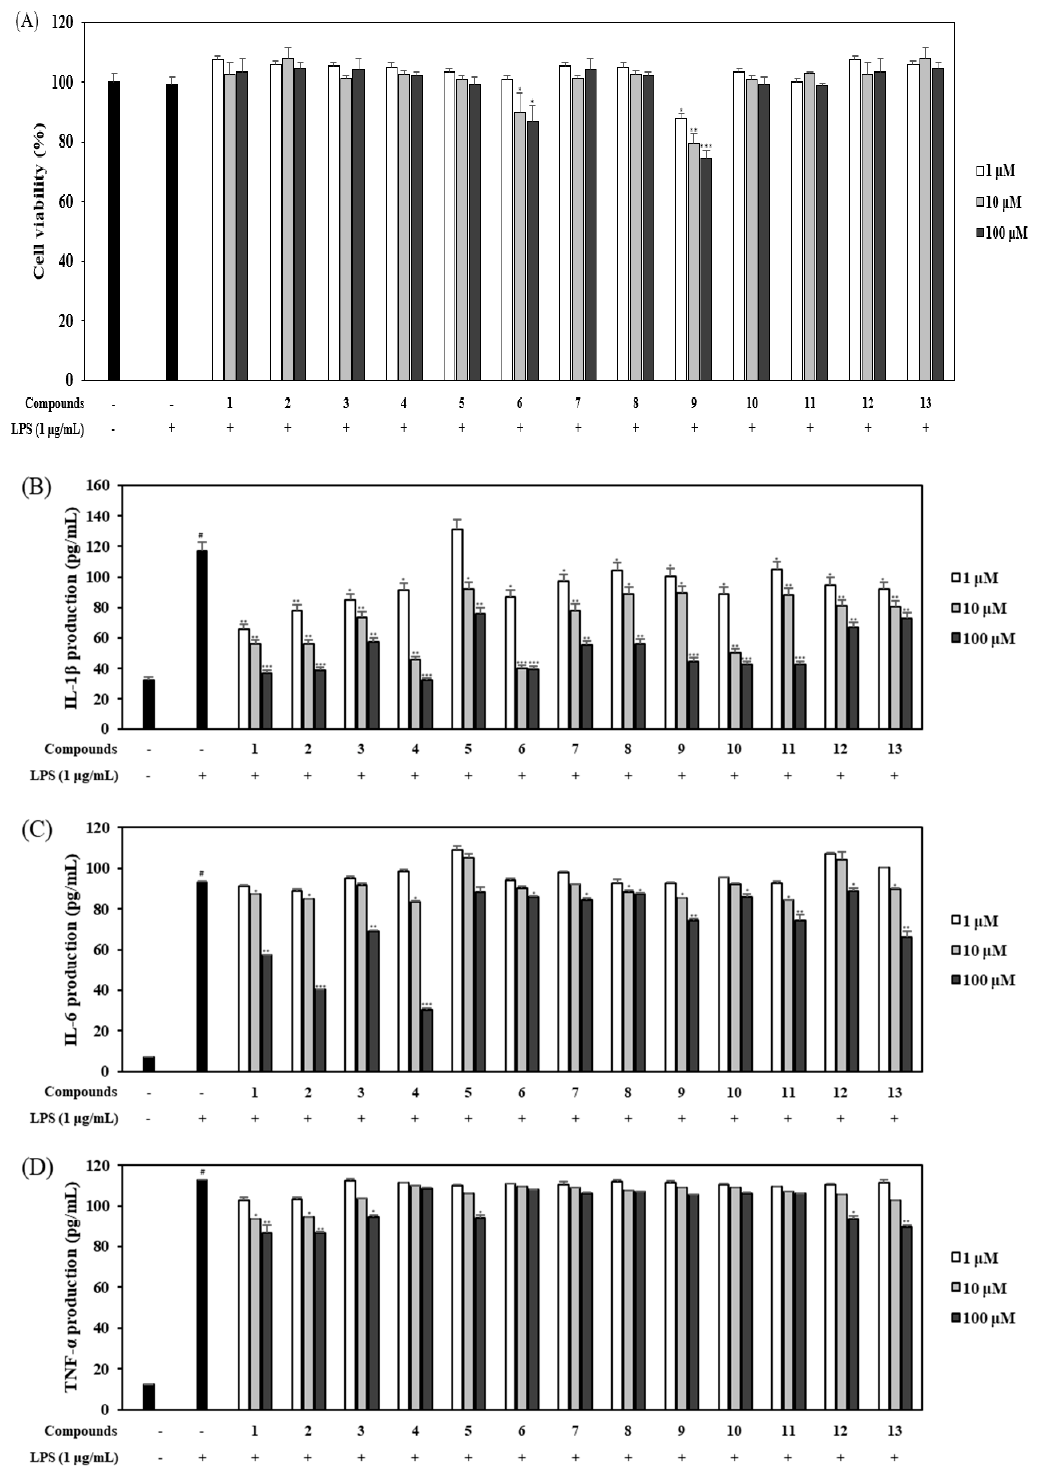
Figure 4. E ff ect of limonoids on the cell viability ( A ) and LPS-induced pro-inflammatory cytokine production ( B – D ). RAW 264.7 cells pretreated with compounds 1 – 13 (1, 10, and 100 µ M) for 2 h were stimulated with 1 µ g / mL LPS for 18 h. Cell viability was determined via MTT assay. The amount of IL-1 β ( A ), IL-6 ( B ), and TNF- α ( C ) in the culture medium was measured with ELISA kits. The values are expressed as mean ± standard deviation of three individual experiments. * p < 0.05, ** p < 0.01, *** p < 0.001, compared to the control